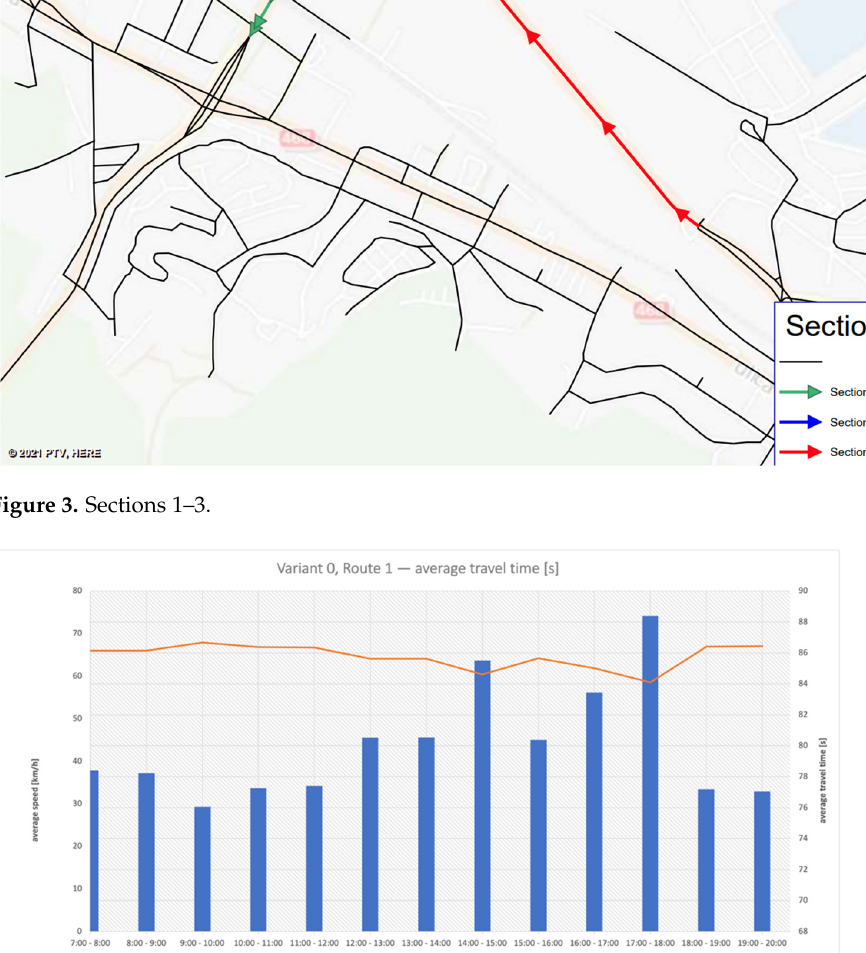
Figure 5. Variant 0; Section 2—average travel time [s].